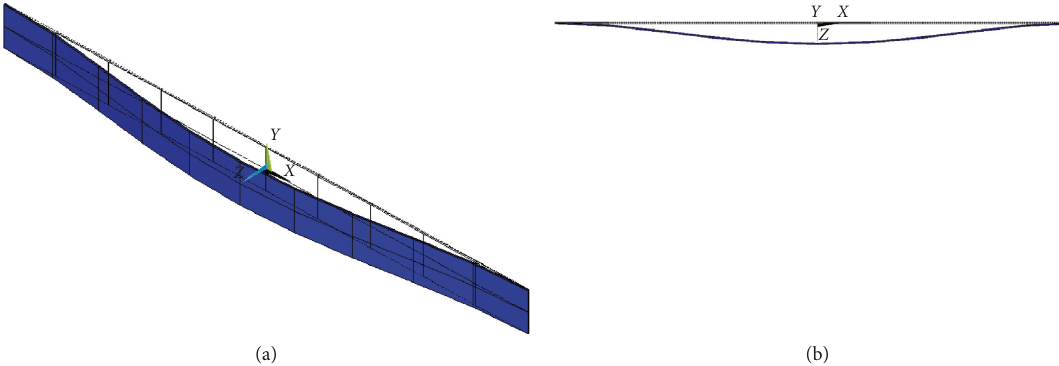
Figure 10: FEM model of the thin-walled beam with laterally fixed ends in ANSYS APDL: (a) 3D view and (b) top view.